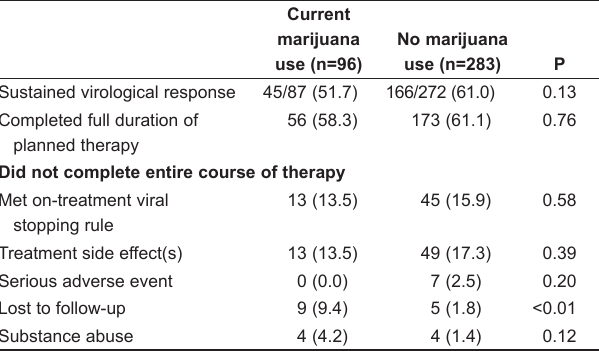
TAble 4 Hepatitis C virus treatment